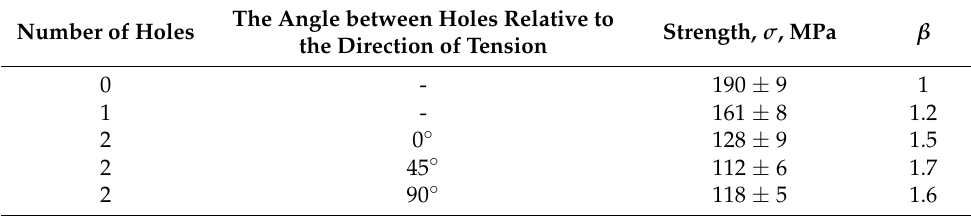
Table 5. Strength and effective stress coefficient for model samples with one and two holes. Number of